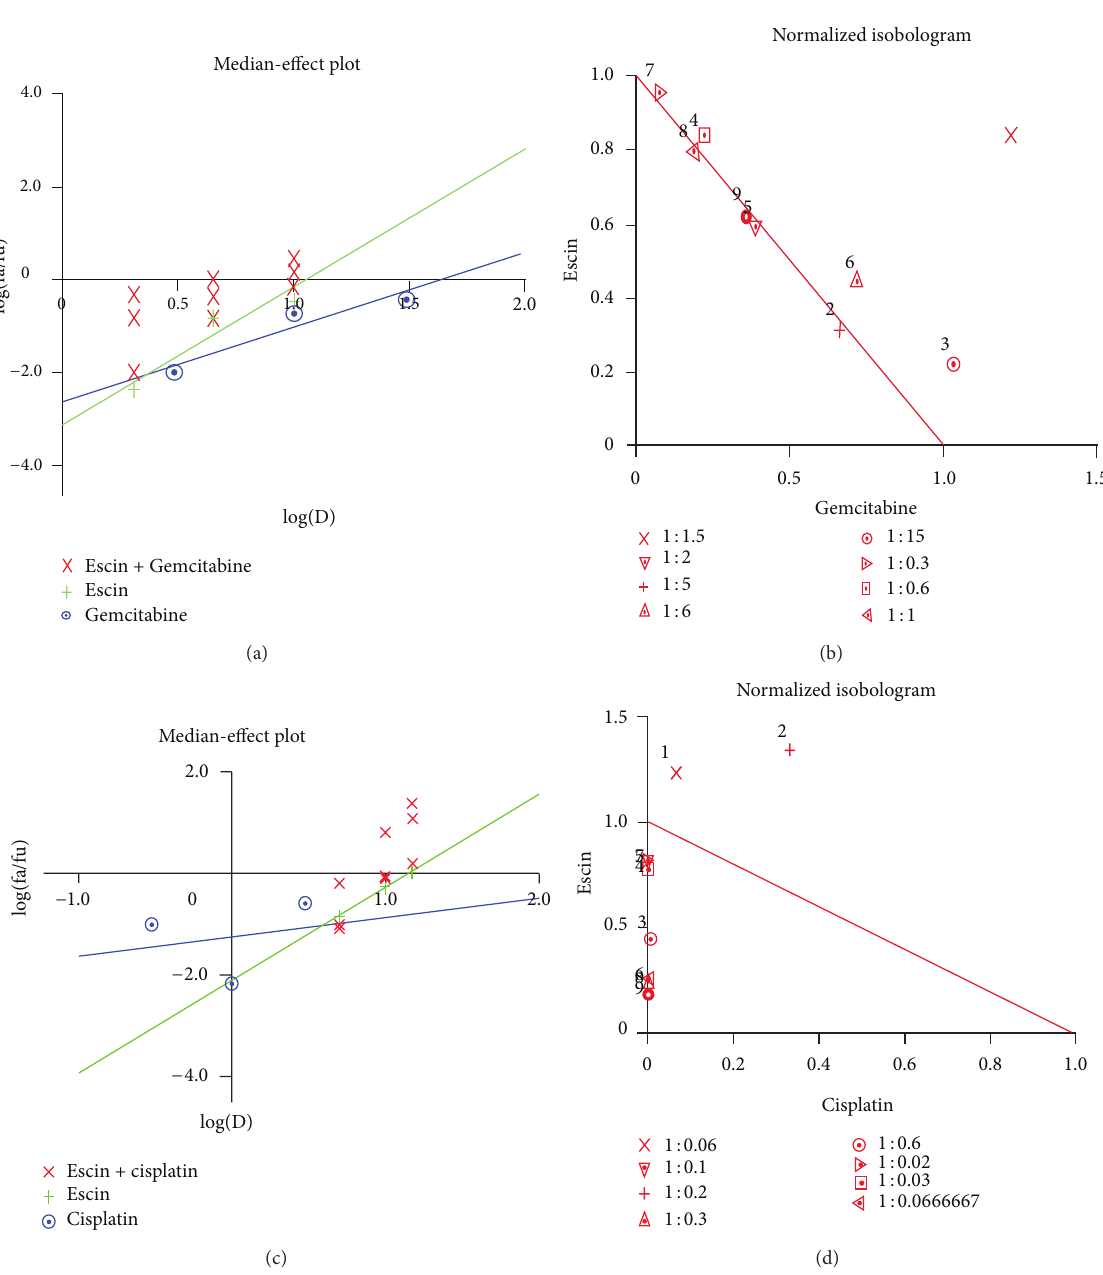
Figure 7: Analysis of combined effect of chemotherapy and Escin. Escin + gemcitabine, median-effect plot (a); Escin + gemcitabine, normalized isobologram (b); Escin + cisplatin, median plot effect (c), Escin + cisplatin, normalized isobologram